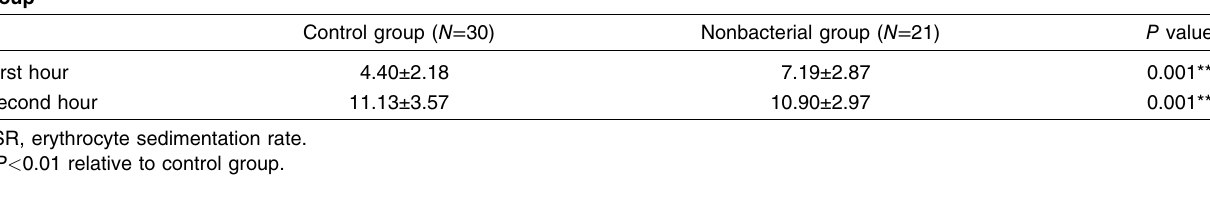
Table 15 Comparison between mean values of ESR (first and second hour) in the bacterial and nonbacterial groups Nonbacterial group ( N = 21) First hour